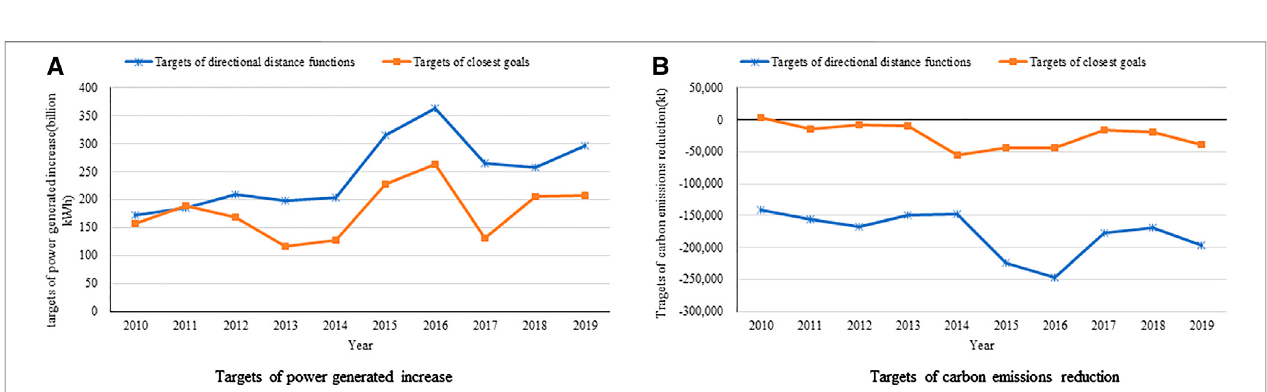
FIGURE 5 | Targets of desirable and undesirable